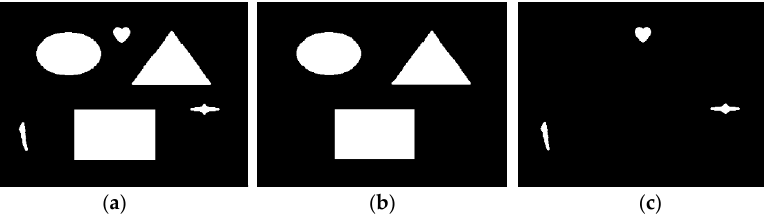
Figure 4. Change detection using the difference of image structuring information: ( a ) the structuring information corresponds to Figure 3a, ( b ) the structuring information corresponds to Figure 3b, and ( c ) the truly changed regions.